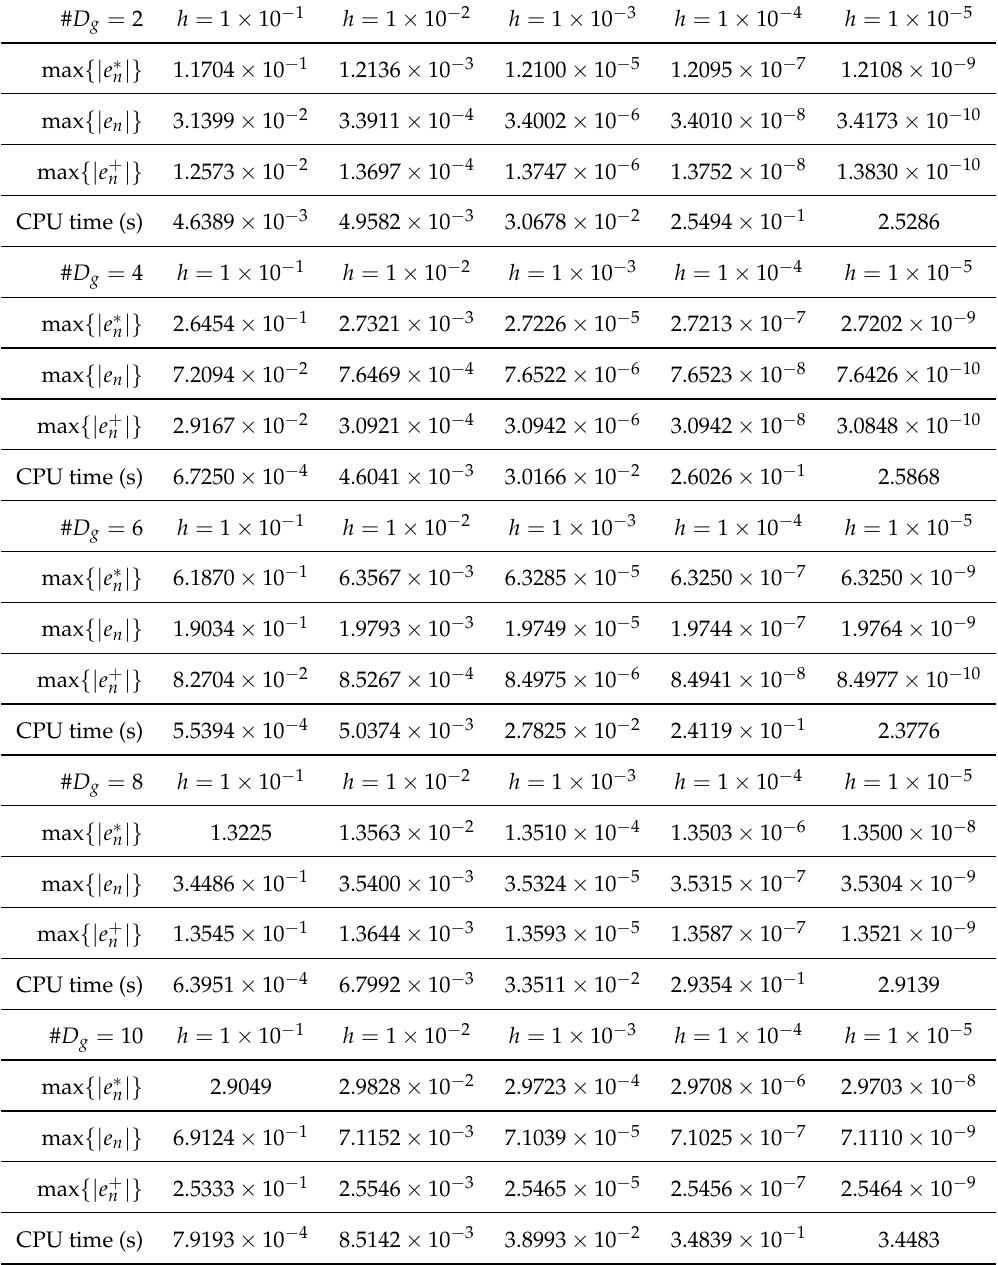
Table 1. Numerical results (linear